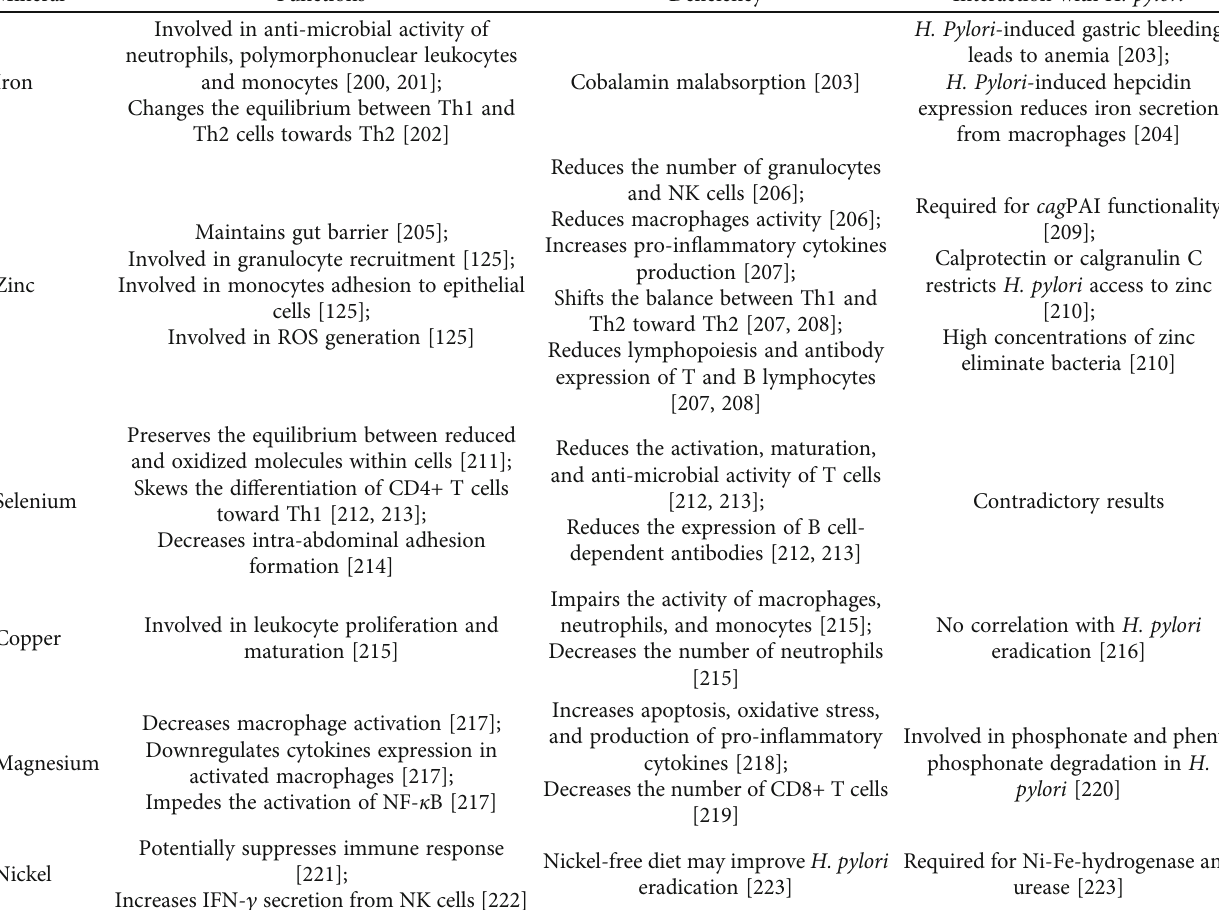
Table 3: The in fl uence of minerals bioavailability on the host and H. pylori pathogenicity.